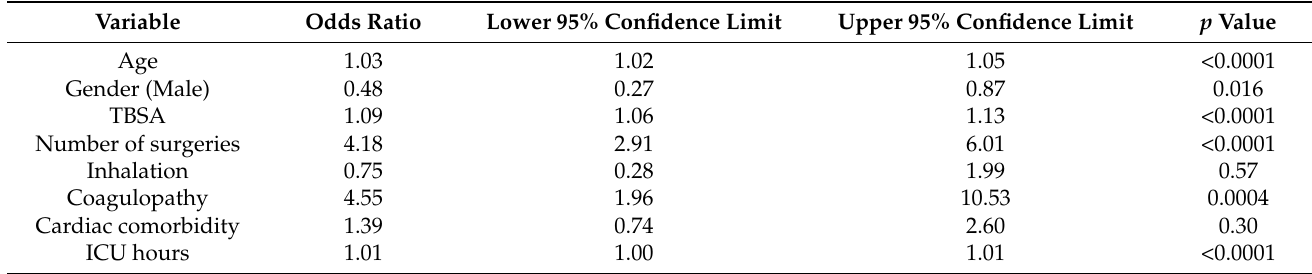
Table 3. Transfusion risk